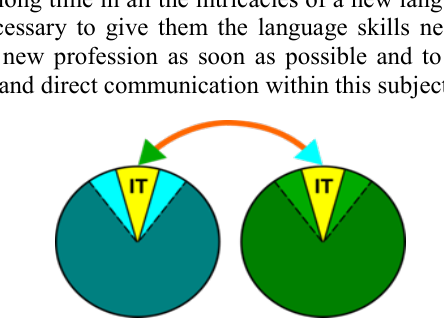
Fig. 2. Interaction between native speakers of different languages within the same subject area